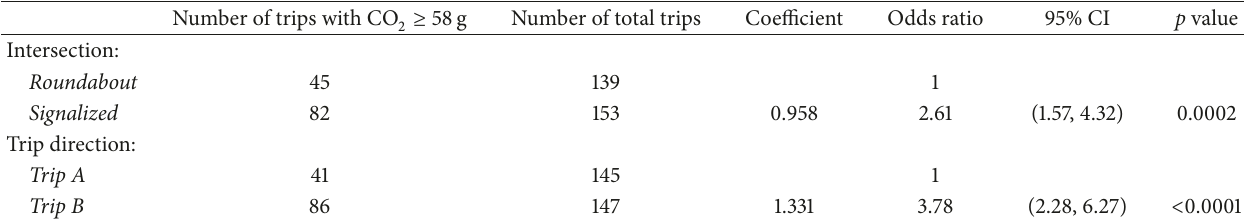
Table 9: Logistic regression relating risk of “high” CO 2 emissions to intersection type and trip direction. Number of trips with CO 2 ≥ 58 g